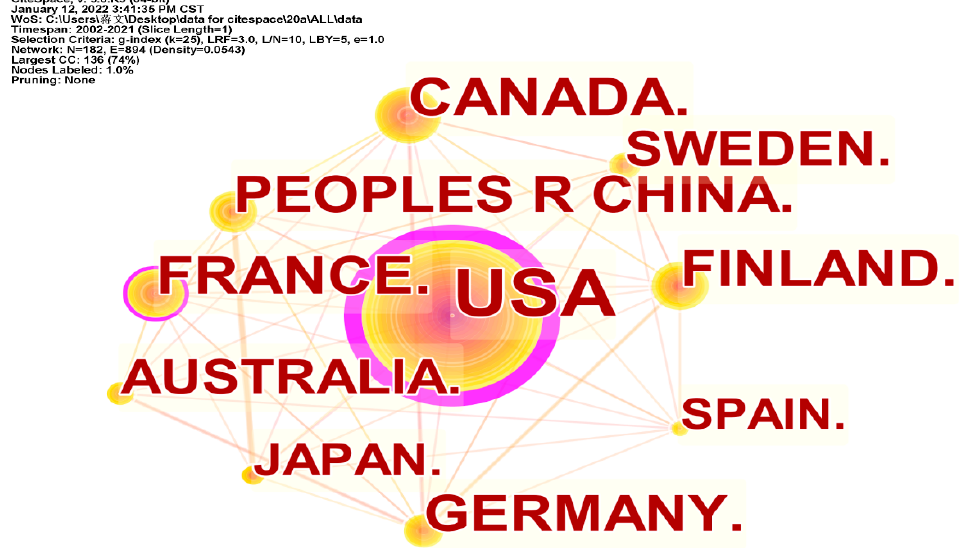
Figure 6. The network of country cooperation.